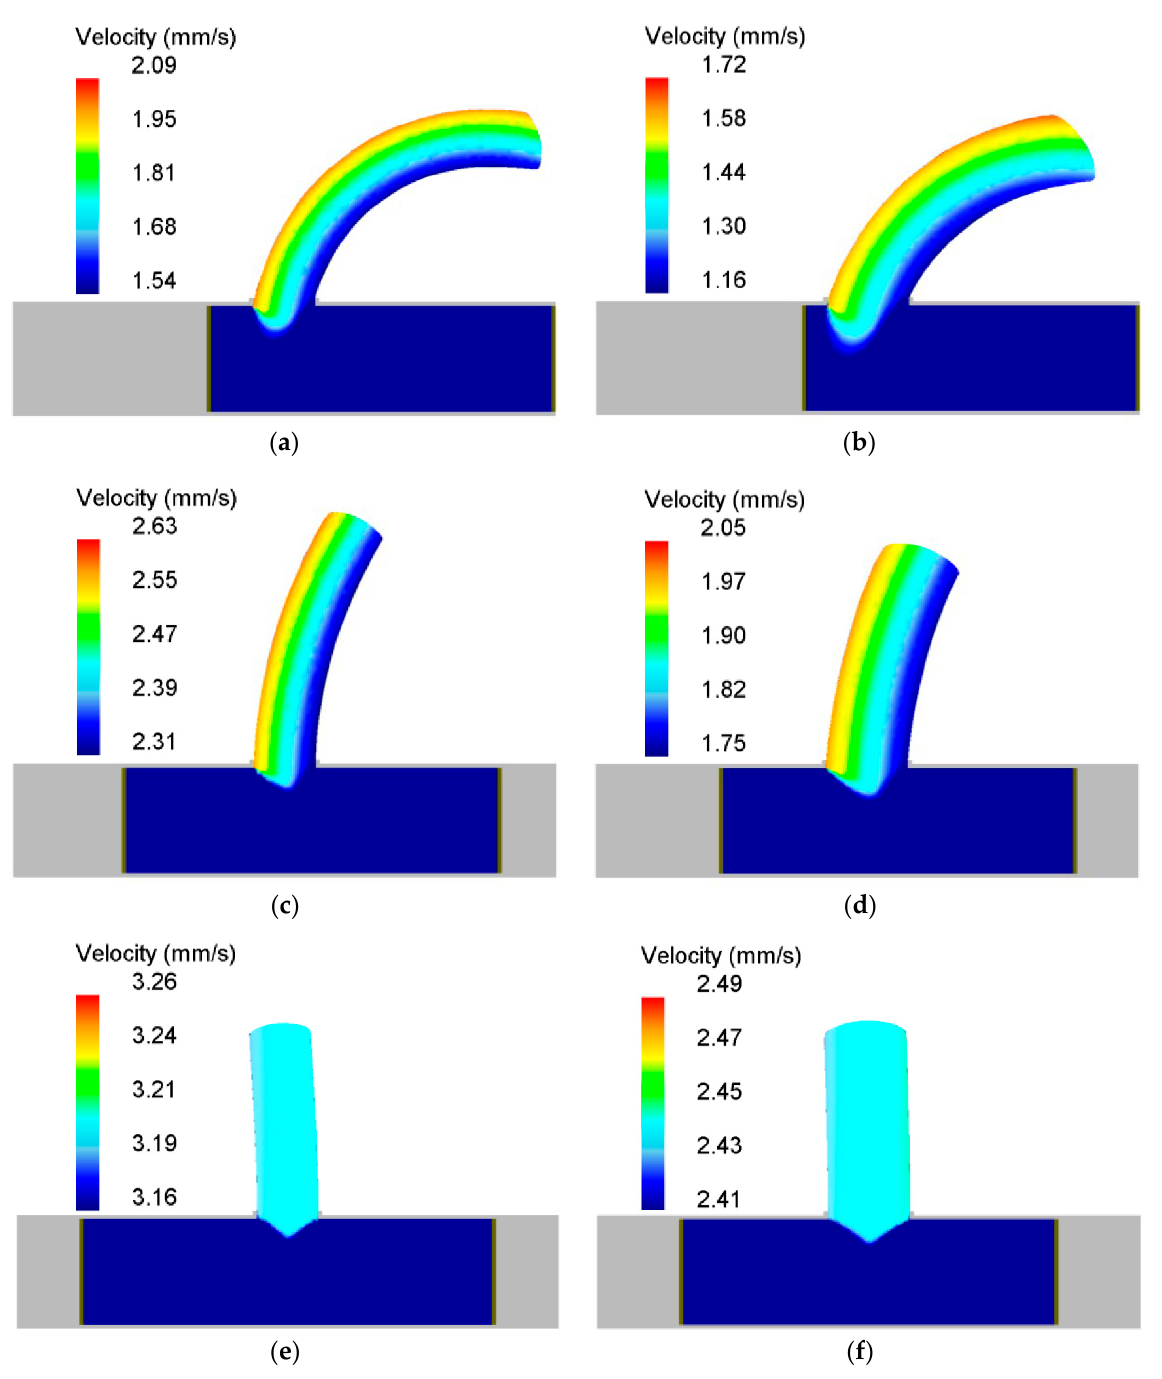
Figure 5. Simulated material flow velocity distribution at different extrusion ratios and velocity ratios, highlighting the velocity gradient of the extruded profile across the die orifice: ( a ) v 2 / v 1 = 0, λ = 1.71, ( b ) v 2 / v 1 = 0, λ = 1.28, ( c ) v 2 / v 1 = 0.5, λ = 1.71, ( d ) v 2 / v 1 = 0.5, λ = 1.28, ( e ) v 2 / v 1 = 1, λ = 1.71 and ( f ) v 2 / v 1 = 1, λ = 1.28.